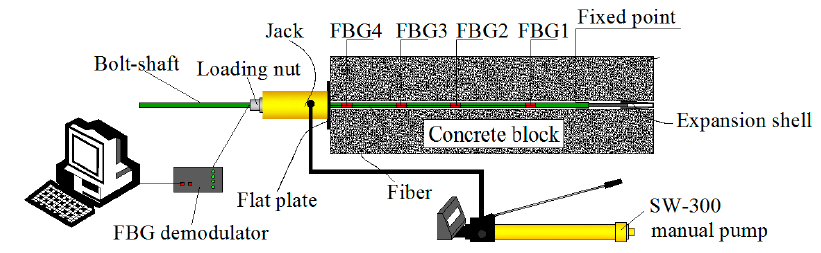
Figure 9. Schematic of the experiment.